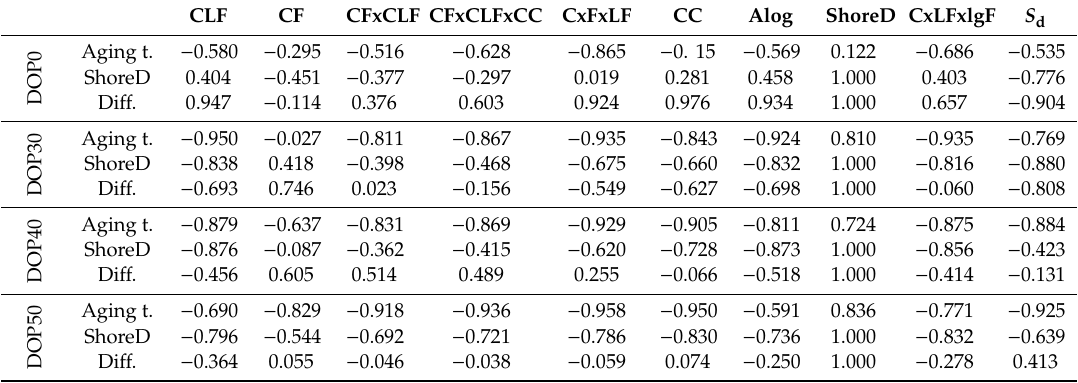
Table 3. Correlations between deducted quantities and equivalent aging time, hardness, and hardness changing of PVC films.